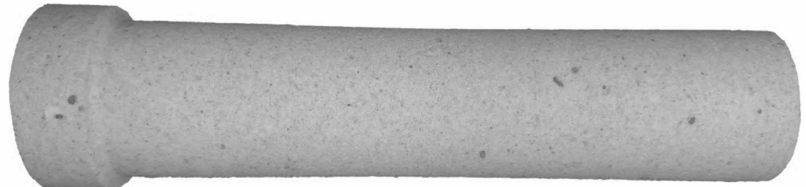
Figure 1. Appearance of a porous ceramic catalytic converter.